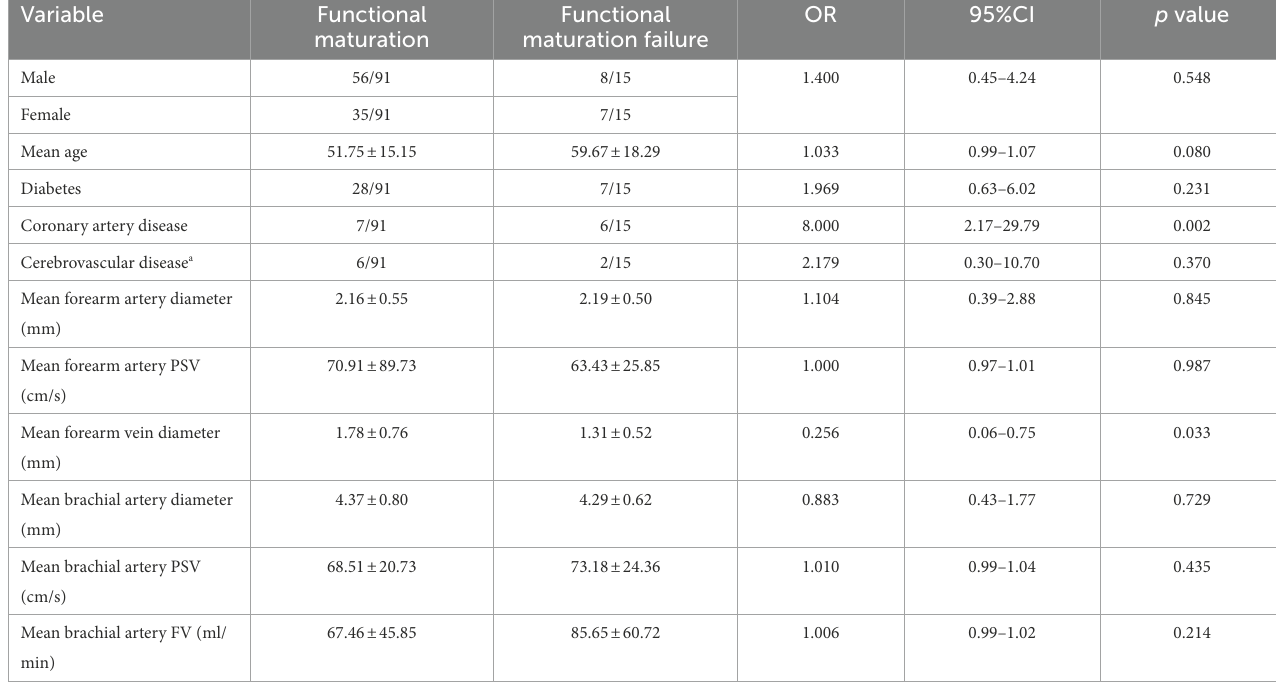
TABLE 3 Logistic regression analysis of risk factors for functional maturation failure in 106 cases with preoperative ultrasound data. Variable Functional Functional maturation maturation